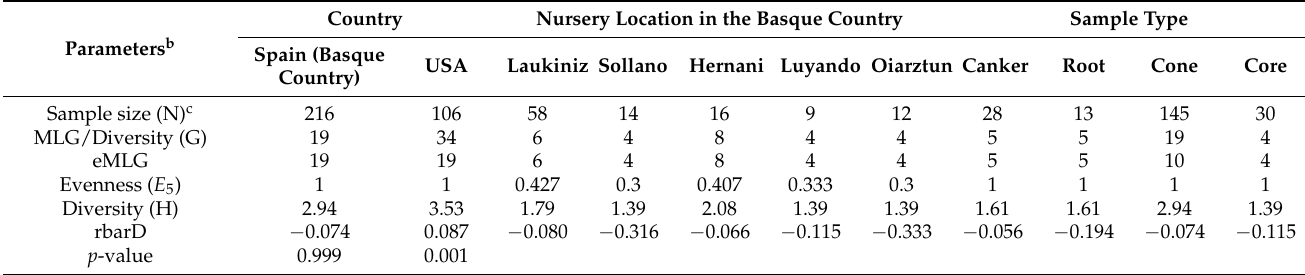
Table 2. Genetic diversity and linkage disequilibrium among loci based on the standardized index of association (rbarD) of Diplodia sapinea populations defined by country of origin, by nursery location in the Basque Country and by sample type a .